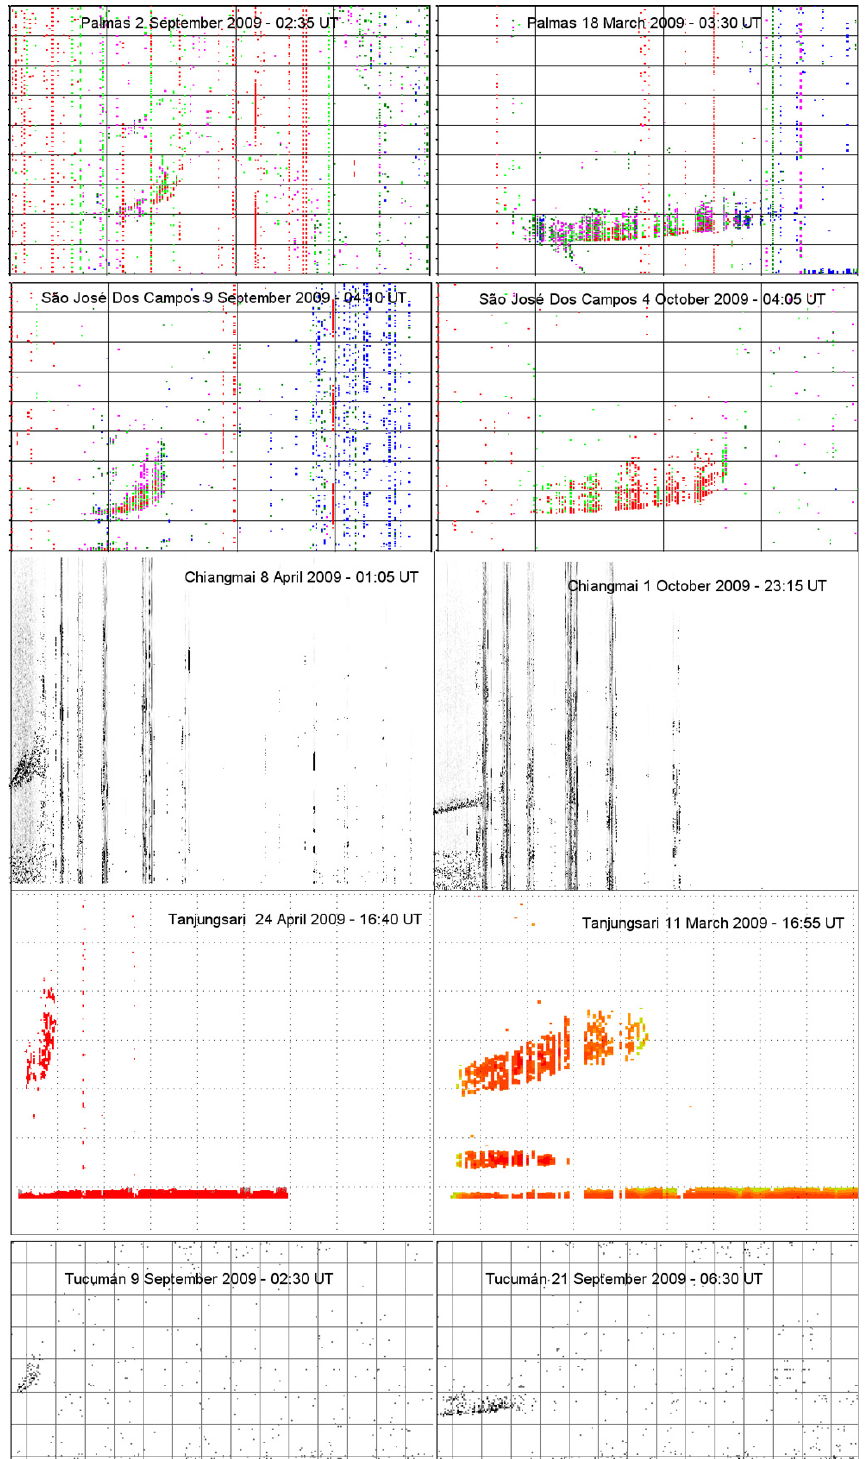
Fig. 3. Examples of FSF (in the left column) and RSF (in the right column) recorded at each of the ionospheric stations considered in the